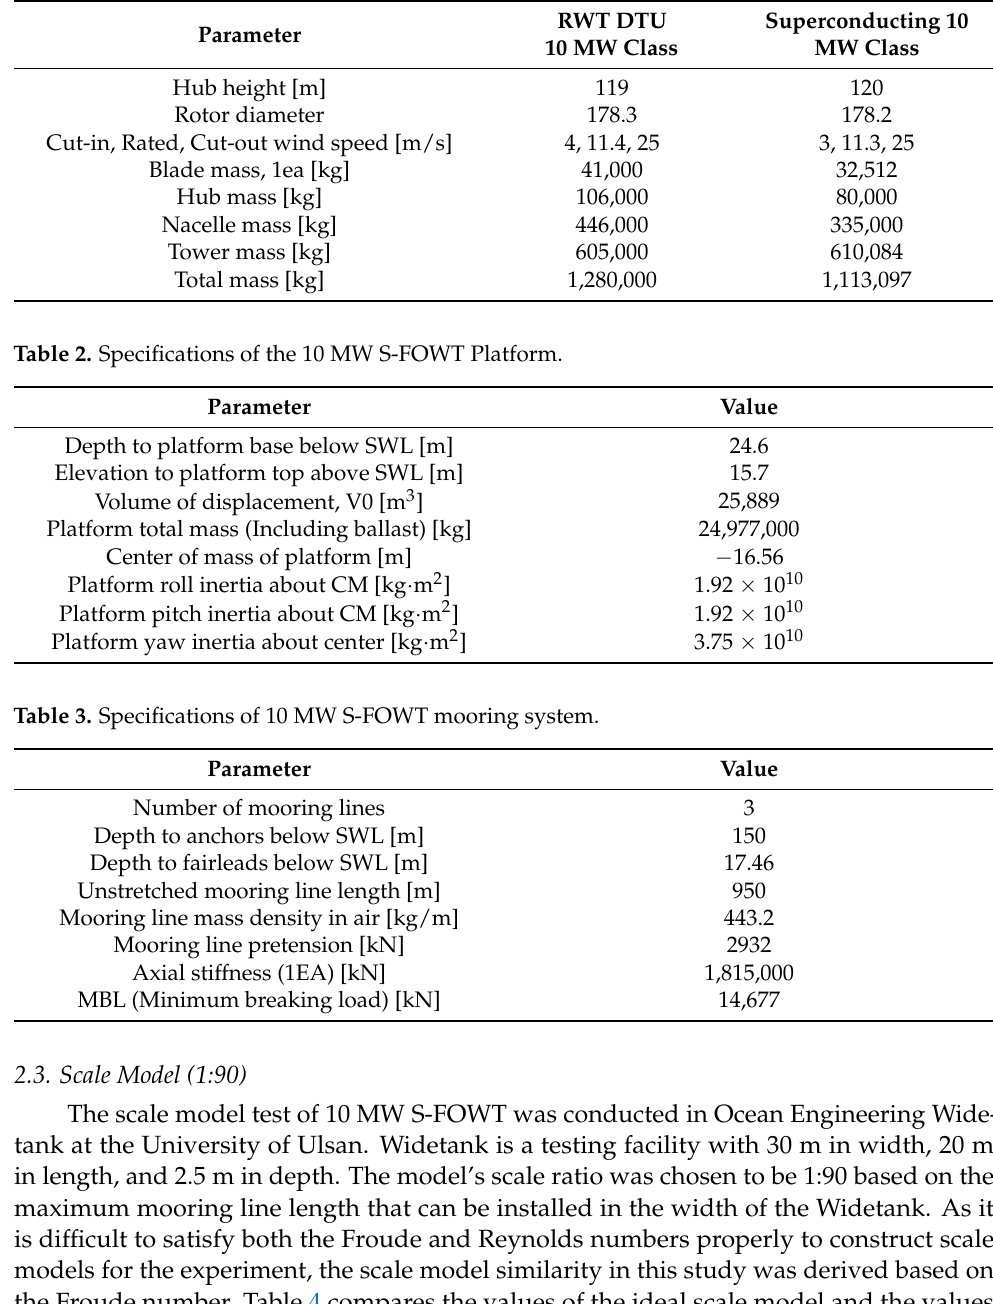
Table 1. Specifications of a 10 MW class wind turbine.